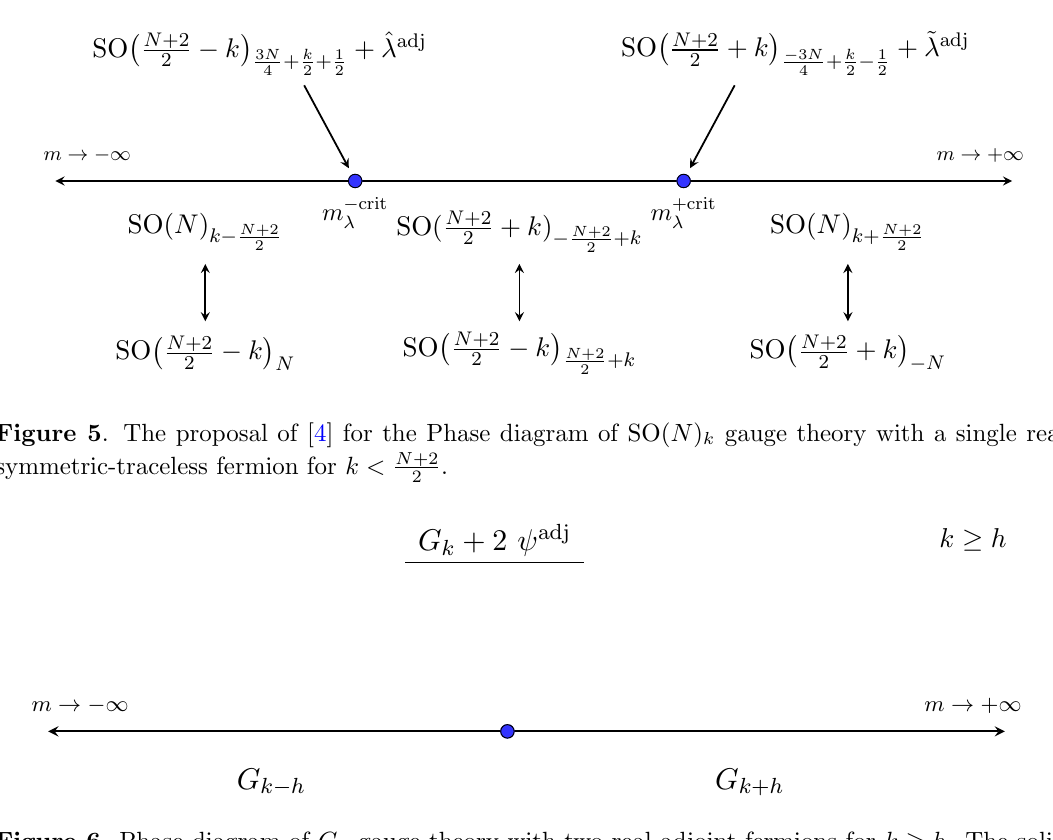
Figure 6 . Phase diagram of G k gauge theory with two real adjoint fermions for k (cid:21) h . The solid circle represents a phase transition between the asymptotic phases. For su(cid:14)ciently large k we know for certain [1, 2] that the phase transition is associated with a